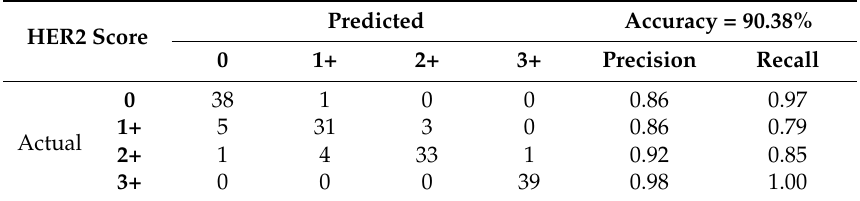
Table 6. Confusion matrix for the multi-class logistic regression algorithm with uLBP feature vectors.